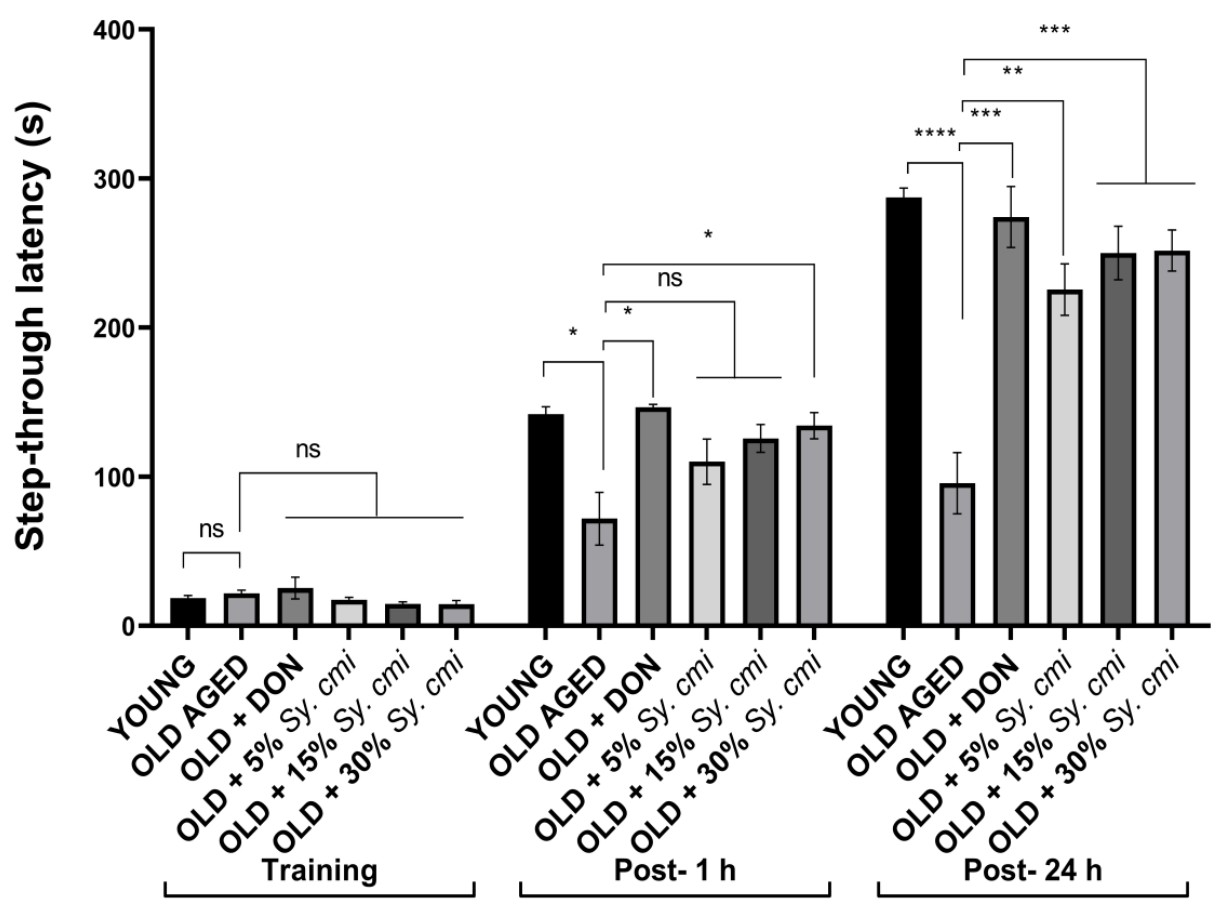
Figure 7. The mice ( n = 8) supplemented with 5, 15, and 30% dilutions of Sy. cmi for 16 months were tested for learning and memory in a passive avoidance test. The animals’ cognitive ability was tested by monitoring their remembrance of aversive stimuli in two sessions of 5 min duration carried out after 1 h and 24 h of the training session, and avoidance of aversive stimuli zone was expressed as step-through latency. The outcomes of all groups were compared with the aged control group and * p < 0.05, ** p < 0.01, *** p < 0.001, **** p < 0.0001 were considered statistically significant while ns showed non-sgnificant outcomes for all data presented as mean ± SEM.